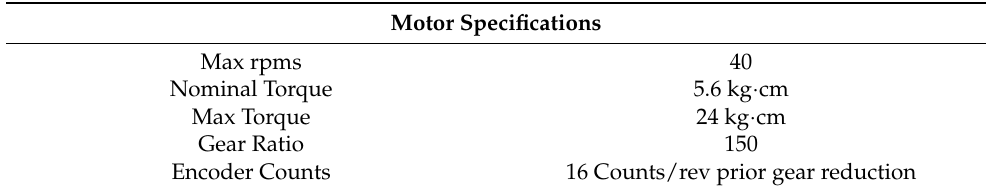
Table 1. Motor specifications.